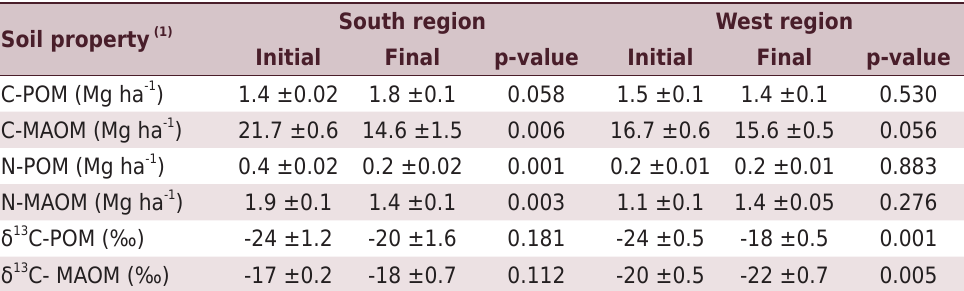
Table 2. Carbon (C) and nitrogen (N) stocks of particulate organic matter (POM) and mineral- associated organic matter (MAOM) and carbon isotopic ratio of soil organic matter (SOM)